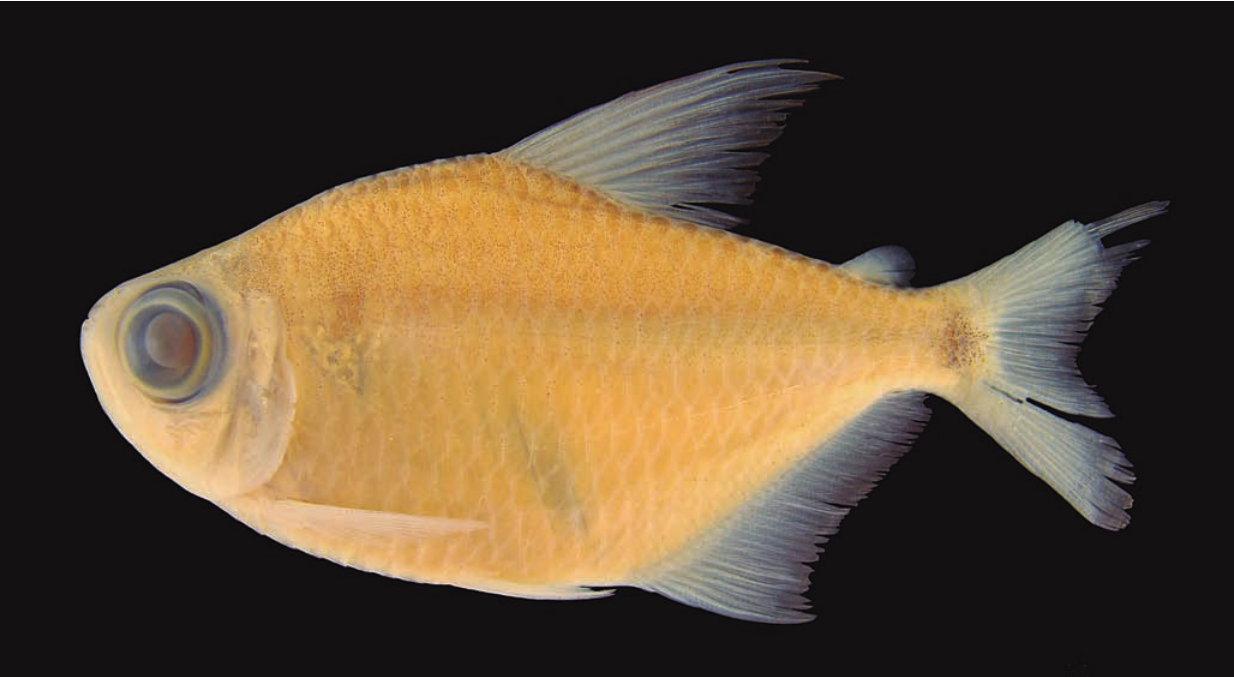
Fig. 1. Tetragonopterus akamai , MCP 48033, holotype, female, 56.5 mm SL, Peixe, rio Tocantins close to confluence with rio Santa